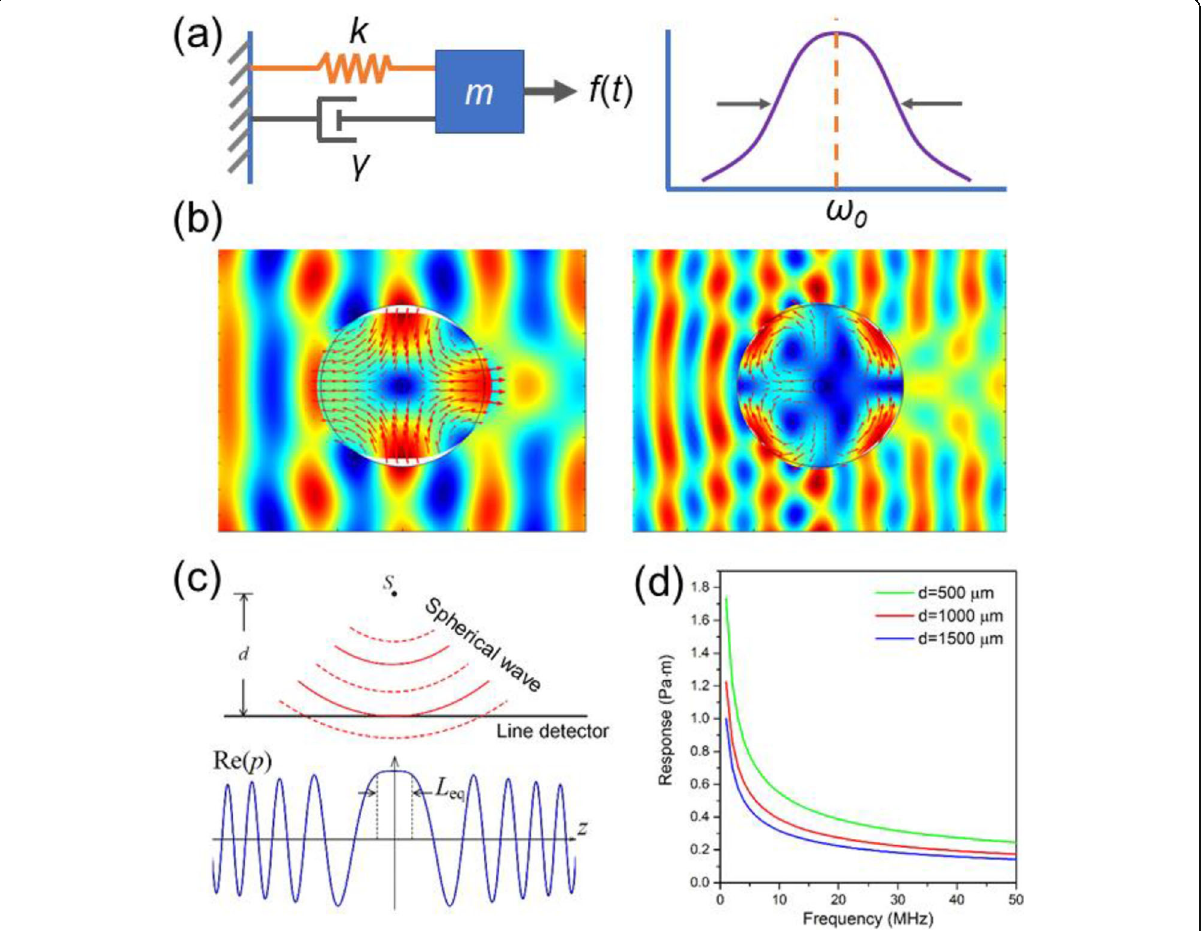
Fig. 7 a Analogous model of a spring-mass oscillator. b Calculated deformation of the fiber surrounded by water in response to planar ultrasound waves. Left: (2,1) torsional-radial mode at 22 MHz. Right: (2, 2) torsional-radial mode at 39 MHz. SRS-based multiwavelength fiber laser source for functional PAM. ( a ): Schematic of the laser and PAM; ( b ): Laser output spectrum; ( c ): Schematic of the phase cancelation effect; and d : Effective interaction length with different source-to-fiber distances